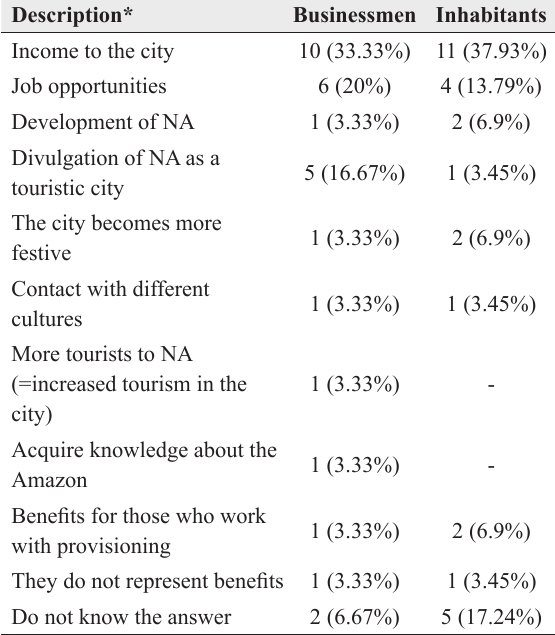
Perception of businessmen and inhabitants about what tourists represent to Novo